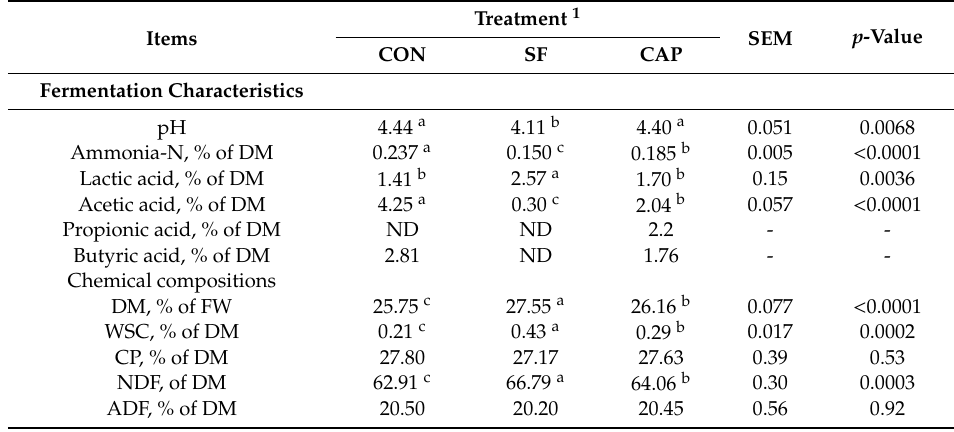
Table 2. Fermentation characteristics, chemical compositions, and in situ e ff ective degradability of ensiled wet brewers grains for 20 days in the presence of sodium formate and calcium